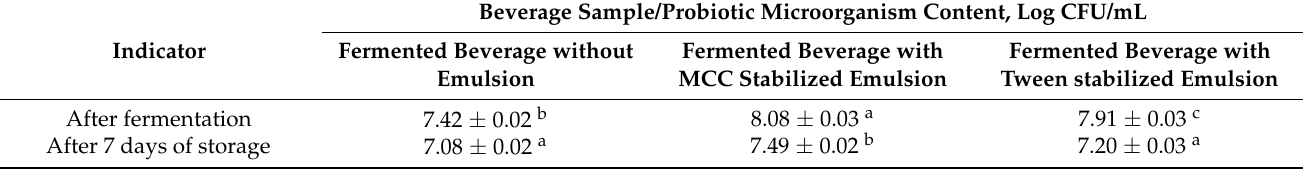
Table 4. Probiotic microorganism content in samples of plant fermented